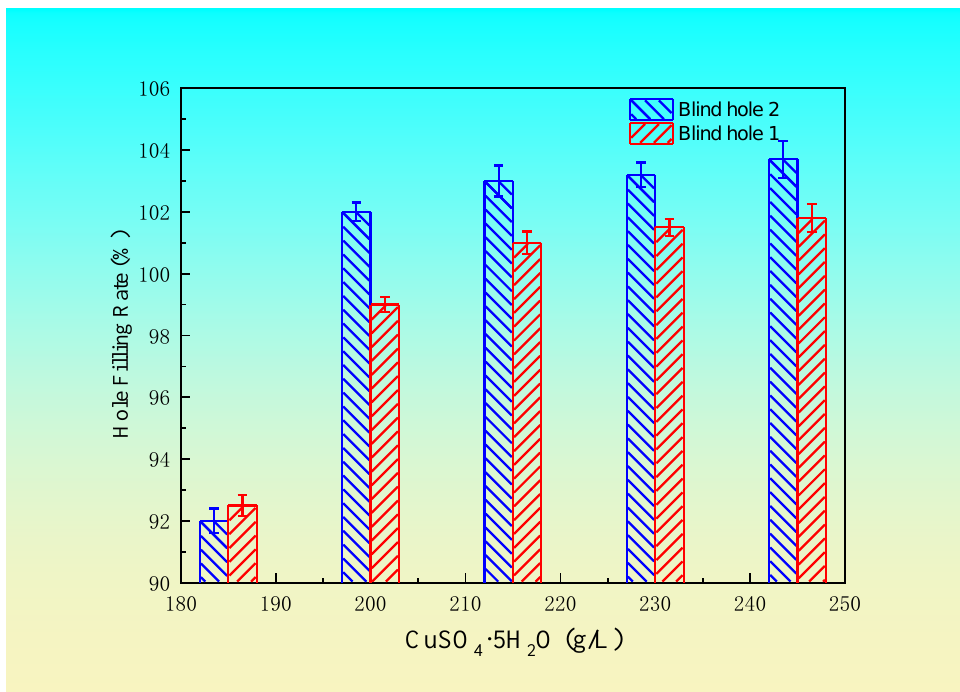
Figure 4. Change in the hole filling rate with the copper sulfate concentration.